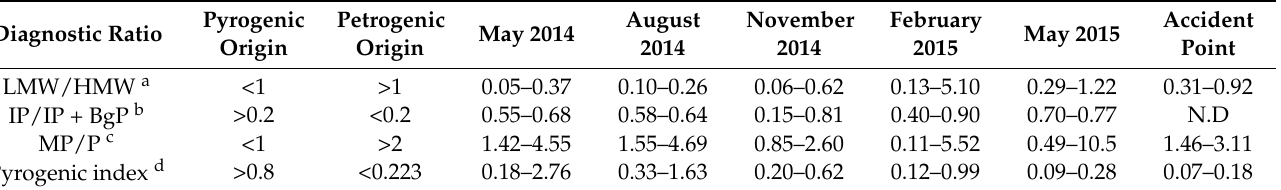
Table 7. Characteristic values of selected molecular ratios for pyrolytic and petrogenic origins of PAHs.